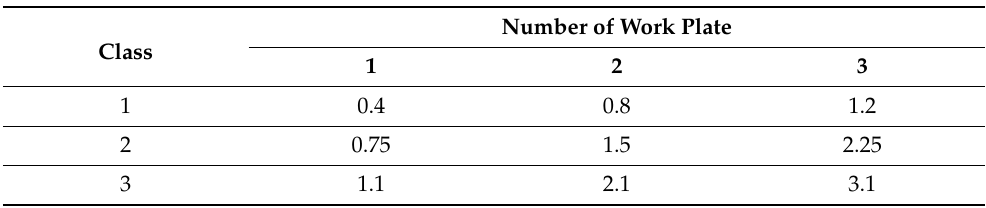
Table 16. Example of safety certification standards for horizontal loads acting on the fabricated mobile scaffold for limiting horizontal